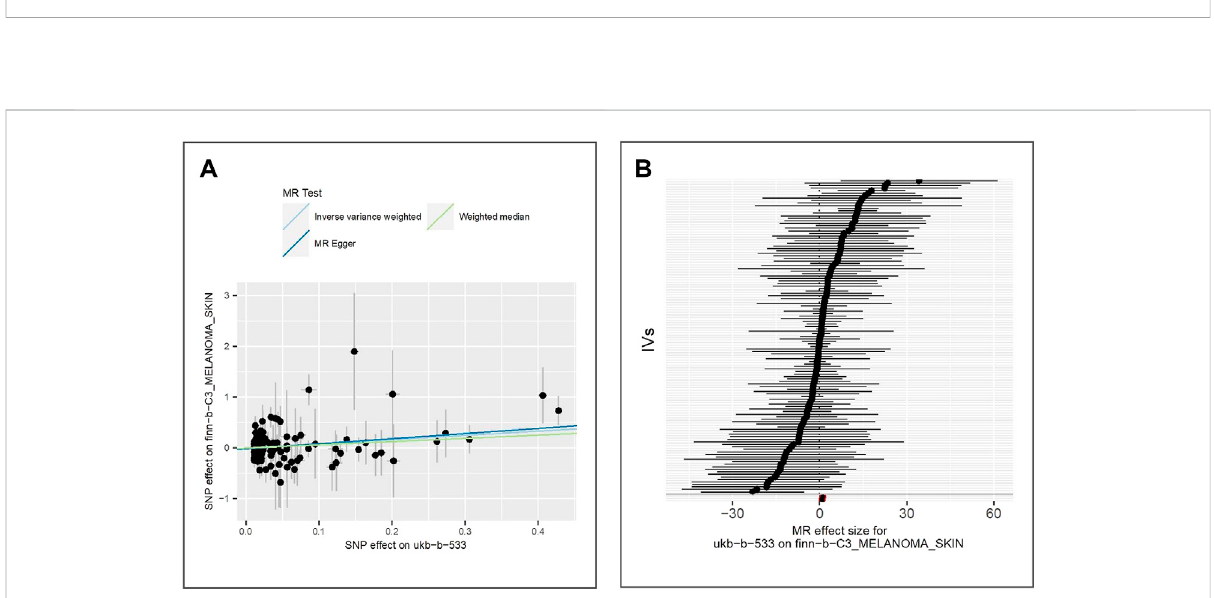
FIGURE 6 Comparison of MR methods and results associated with malignant melanoma of the skin: (A) scatter plot re fl ects SNP effects on the malignant melanomaofskinagainstSNPeffectsontheexposure; (B)